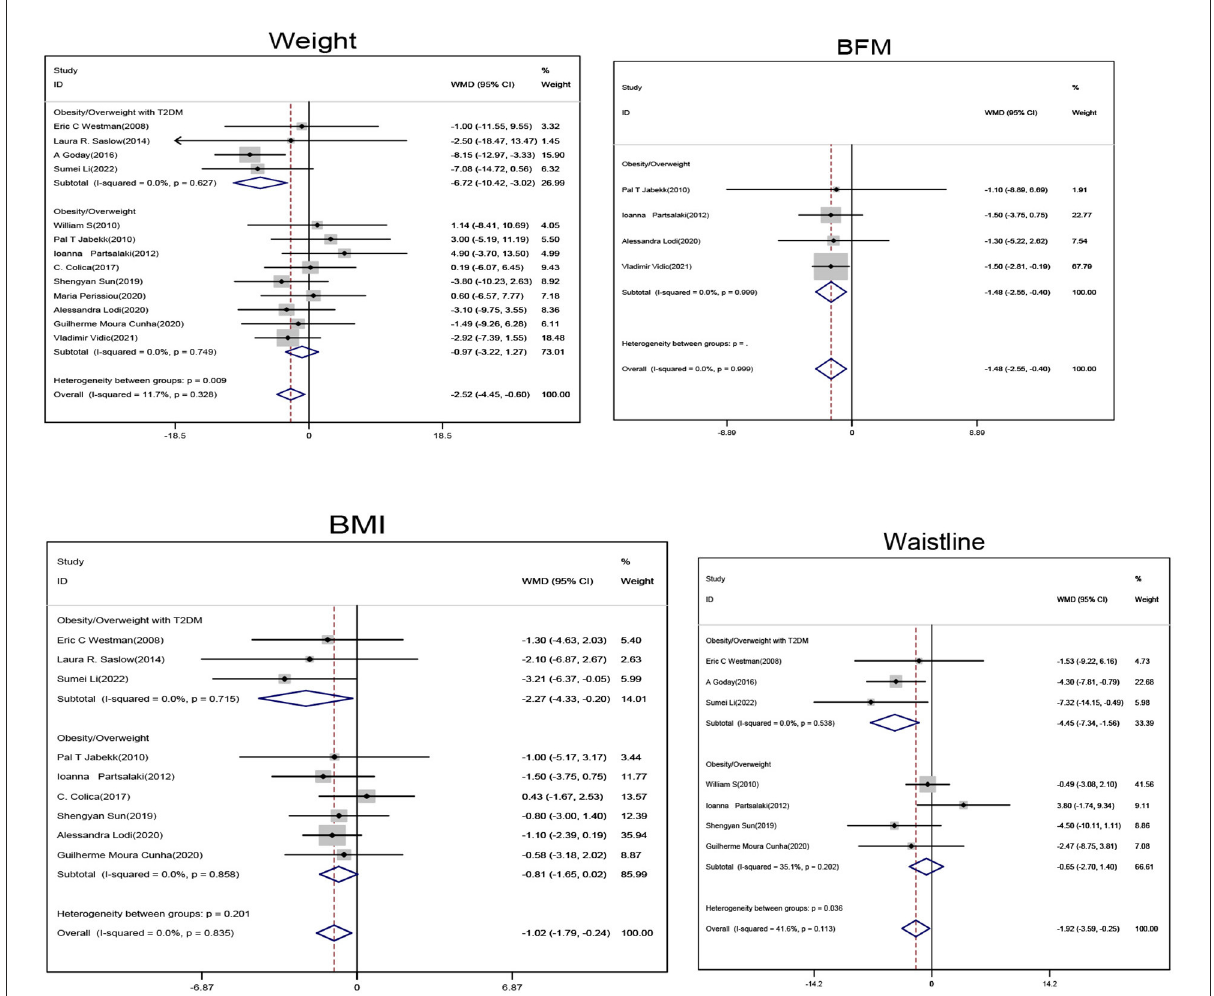
FIGURE3 Forest plot showing weighted mean difference and 95% confidence intervals (CIs) for low carbohydrate ketogenic diet effects on weight control. BFM, Body fat volume; BMI, Body mass